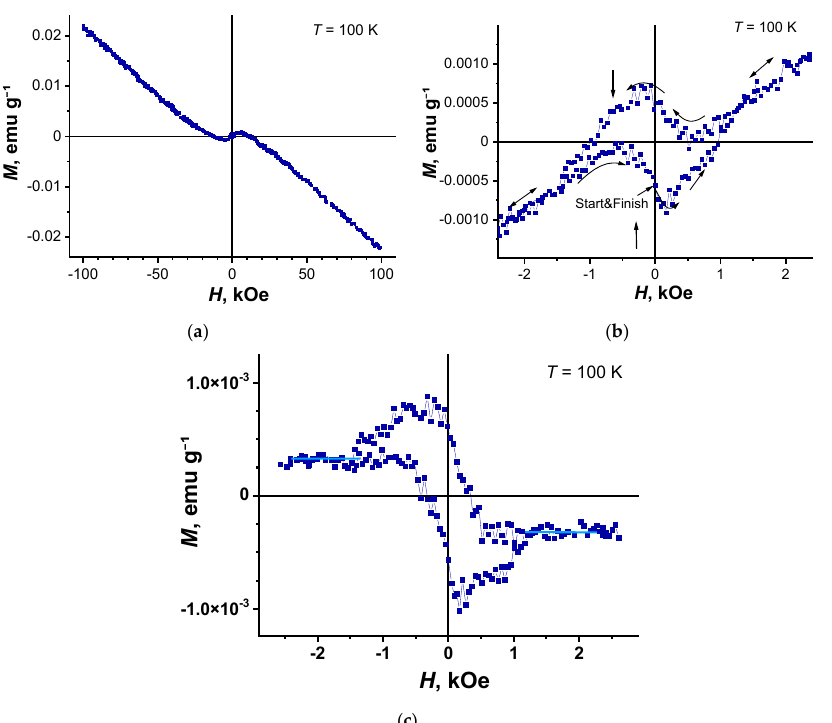
Figure 9. Dependence of the magnetic moment for composite 2 at T = 100 K on the strong ( a ) and weak magnetic fields ( b ). Arrows indicate the peaks of the magnetization loop and field direction ( b ). Magnetization loop after subtracting the diamagnetic and paramagnetic contributions ( c ).